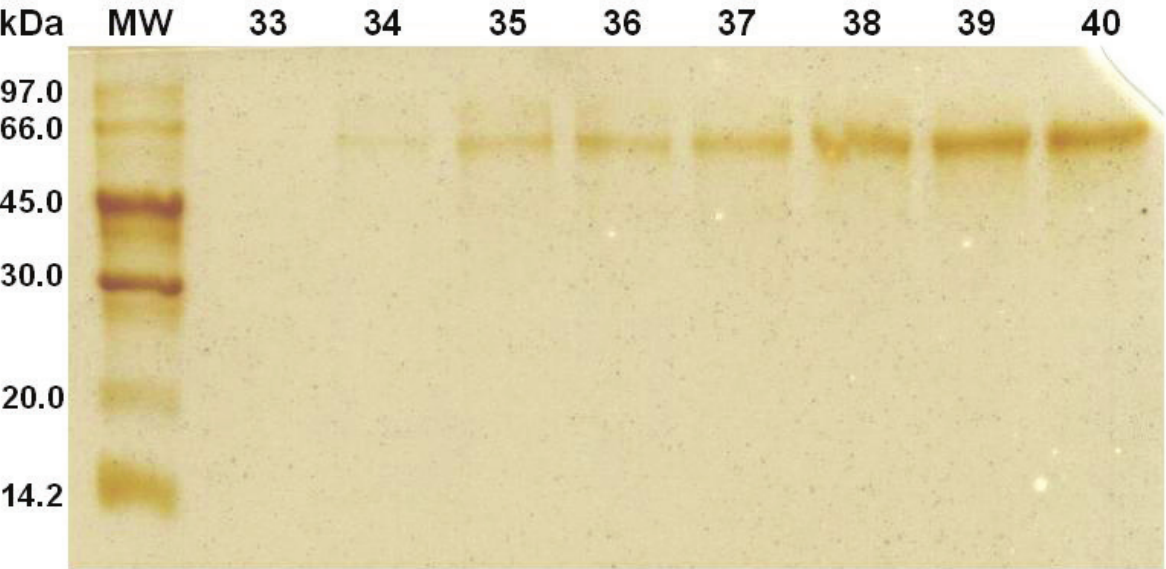
Figure 5. SDS-PAGE of fractions from peak I (Figure 4) obtained in the gel filtration chromatography of the ATPS bottom phase on Sephadex G-75. Numbers at the top of the line indicate the fraction eluted from the chromatographic